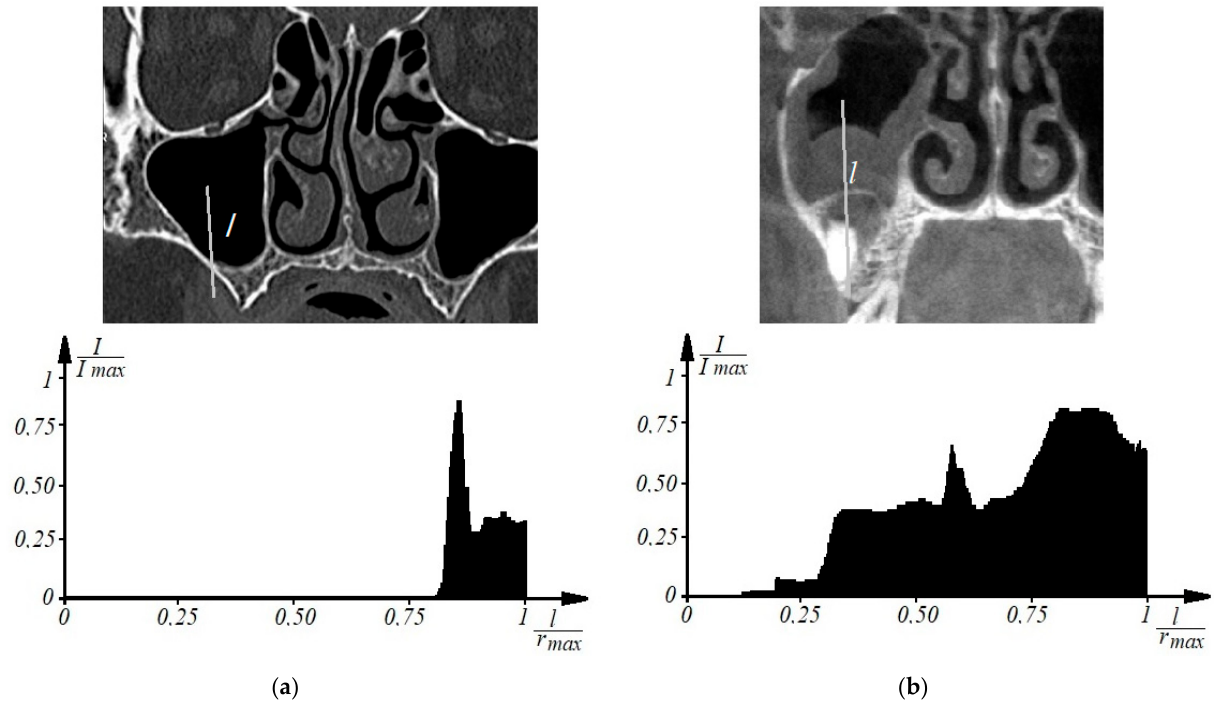
Figure 1. Examples of densitographic analysis according to spiral computed tomography: normal ( a ) and in the presence of a cyst of odontogenic origin in the maxillary sinus ( b ) (above is a tomographic section in coronary projection with the trajectory of the densitogram).